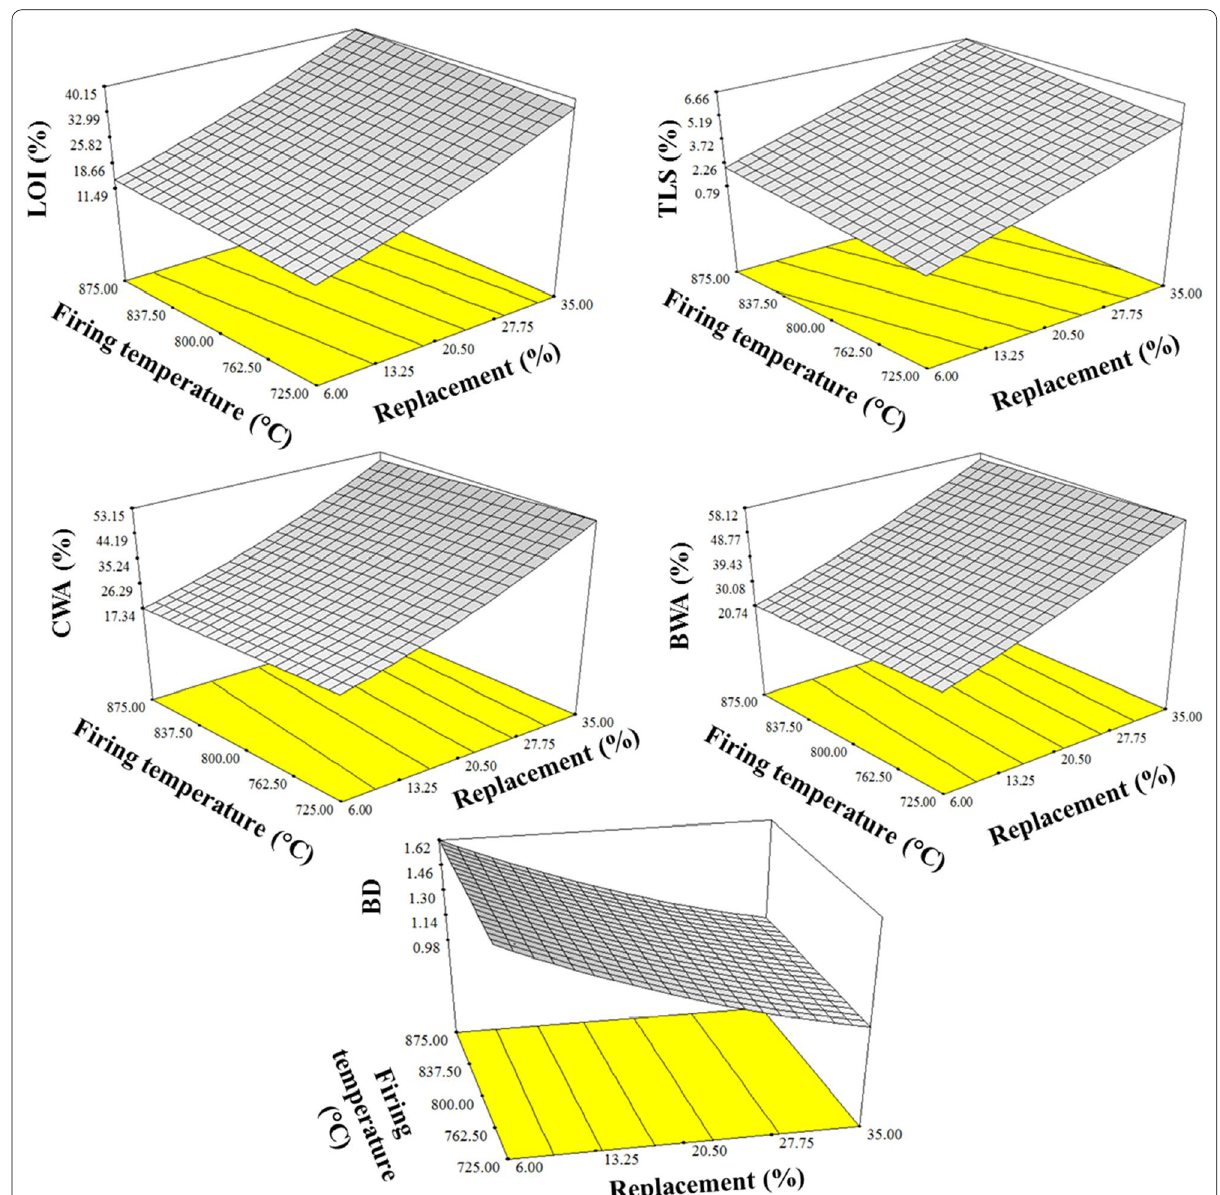
Fig. 8 Three‑dimensional graph for clay‑PA fired bricks models of: LOI, TLS, CWA, BWA, and